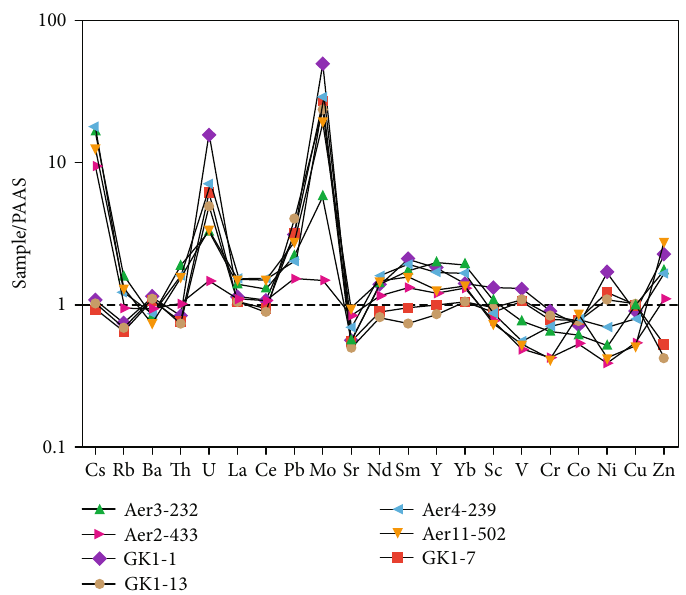
Figure 6: PAAS-normalized plot of trace elements in mudstones (PAAS from [46,